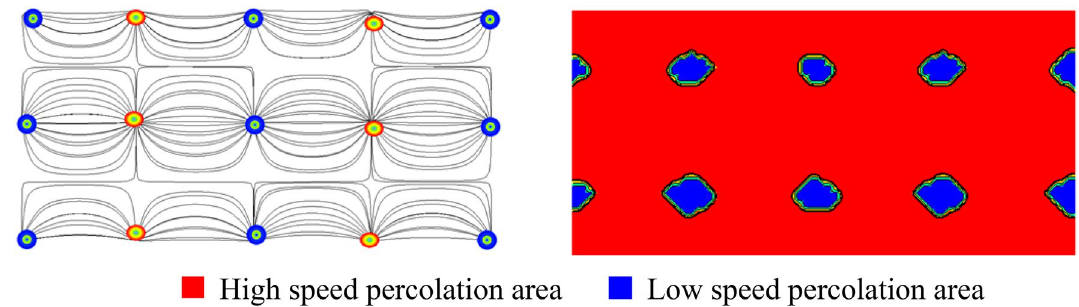
Fig. 4 Schematic diagram of streamline and seepage velocity zone of line well pattern